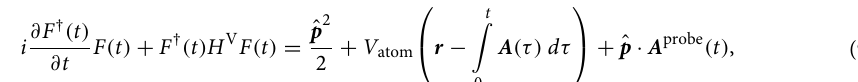
0.04 a.u. ( b ), E 0 0.0534 a.u. ( c ), E 0 = =